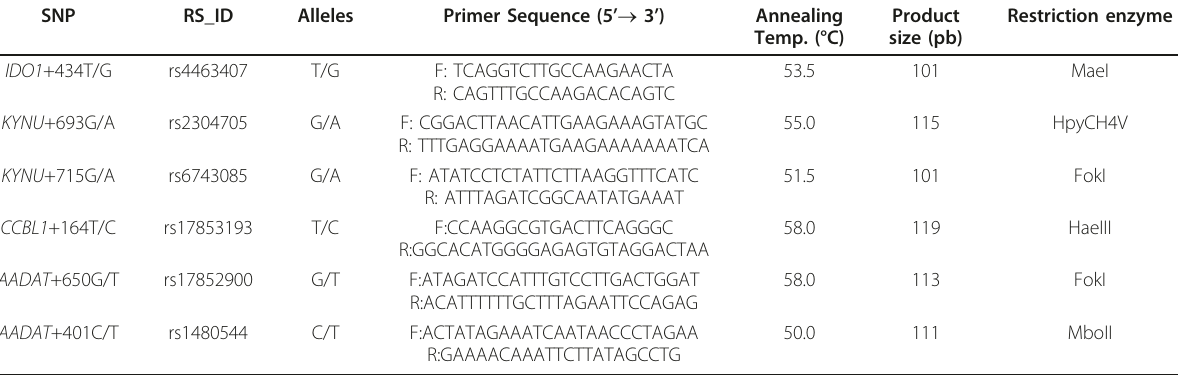
Table 1 SNP data: primer sequences, annealing temperatures, PCR product sizes, and enzyme restrictions SNP RS_ID Alleles Primer Sequence (5 ’ ® 3 ’